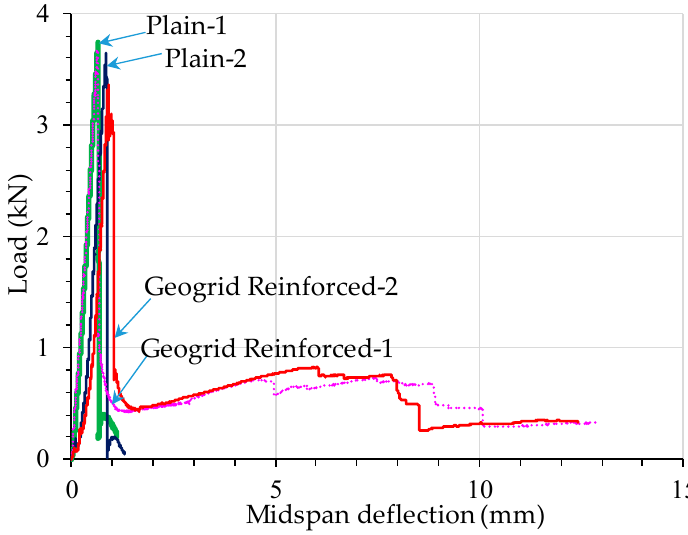
Figure 4. Load-midspan deflection of concrete beams under monotonic flexural loading.